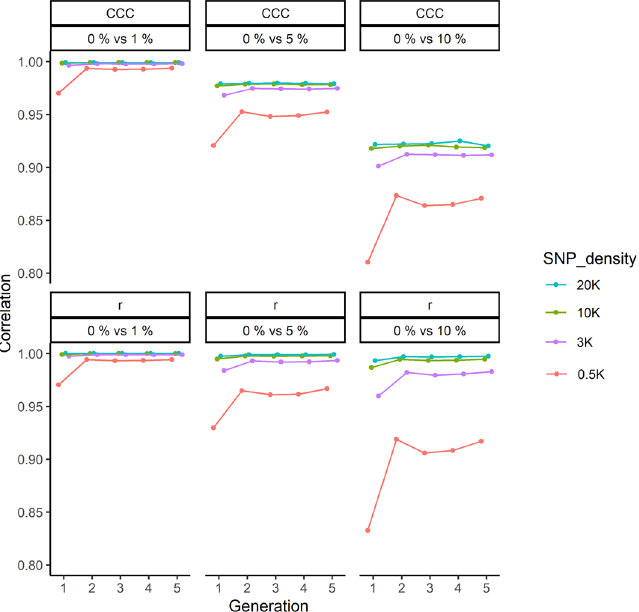
Figure 11. Comparison of off-diagonal elements of genomic relationship matrix (GRM) without error with 1, 5 and 10% error for different SNP densities across five generation. The estimates are averaged across ten replicates, three trait heritabilities (0.5, 0.3 and 0.05) and two family types (equal and unequal). r signifies the Pearson correlation and CCC is Lin’s concordance correlation coefficient. In each plot, the correlation between off-diagonal elements of GRM without error and GRM with 1% (0% vs 1%), 5% (0% vs 5%) and 10% error (0% vs 10%) are illustrated. Standard errors were significantly small and were unable to be